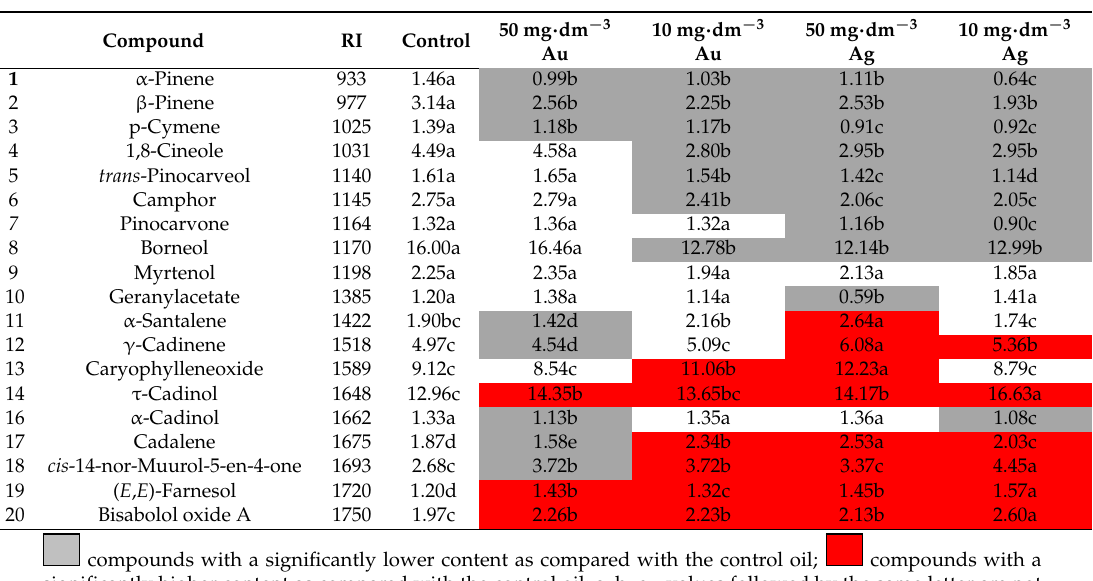
Table 2. Statistical analysis of main